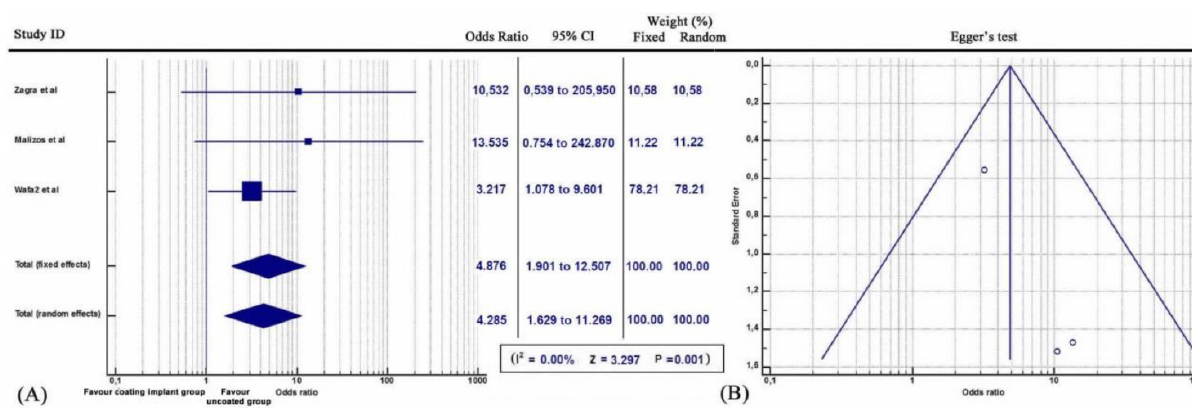
Figure 6. (A) Forest plot showing the likelihood of periprosthetic infections in patients suffering of post-surgical infection, in the coating implant group versus the group without coating implants. (B) Funnel plot of the Egger’s test was utilized to assess for publication